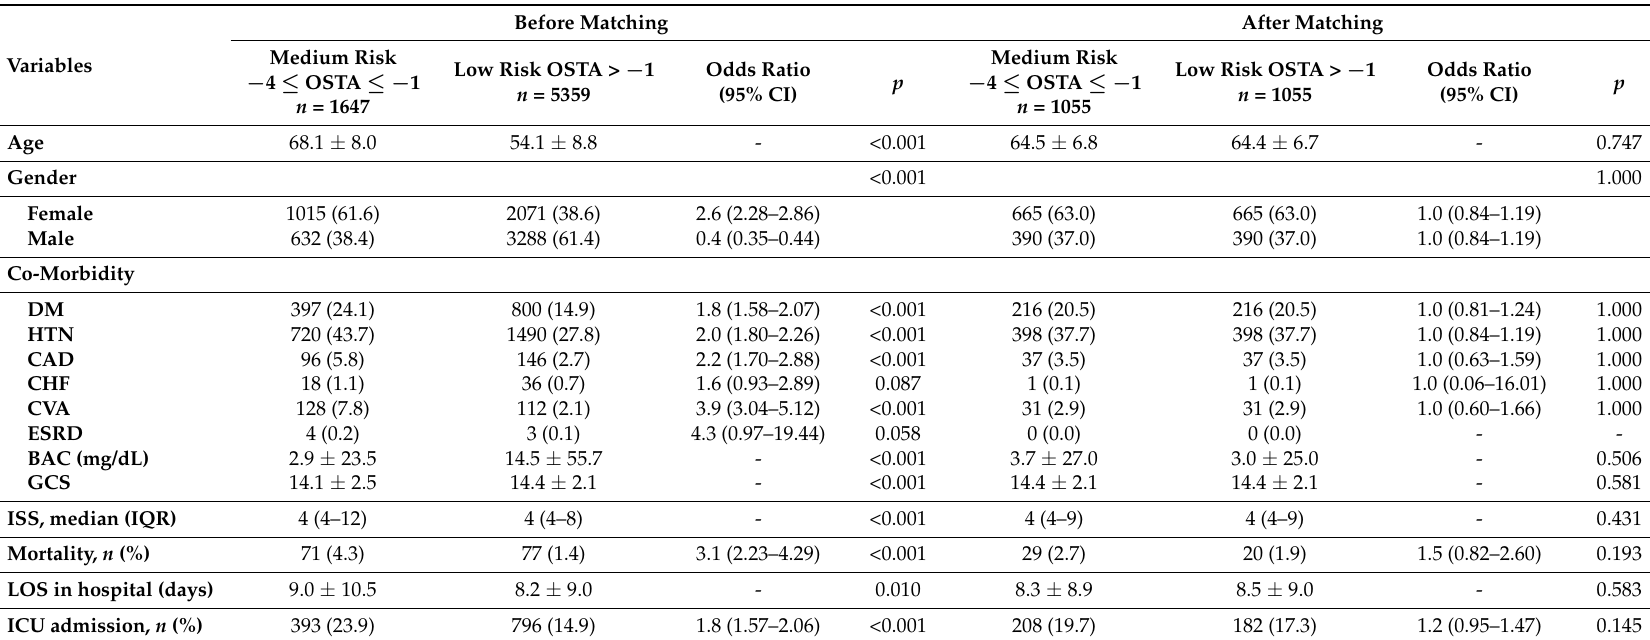
Table 8. Outcome of the medium-risk and low-risk patients before and after propensity score-matching with adjustment of the covariates including age and other